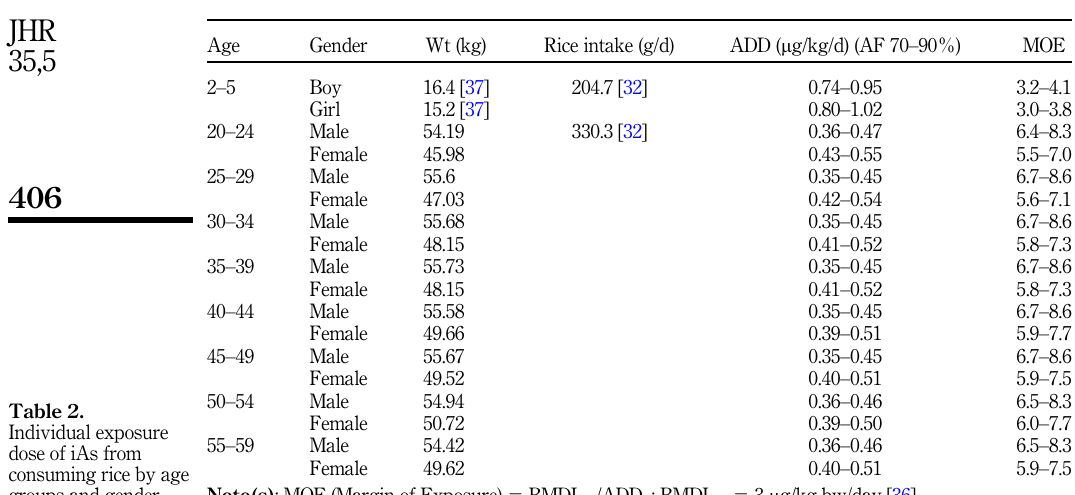
Table 2. Individual exposure dose of iAs from consuming rice by age groups and